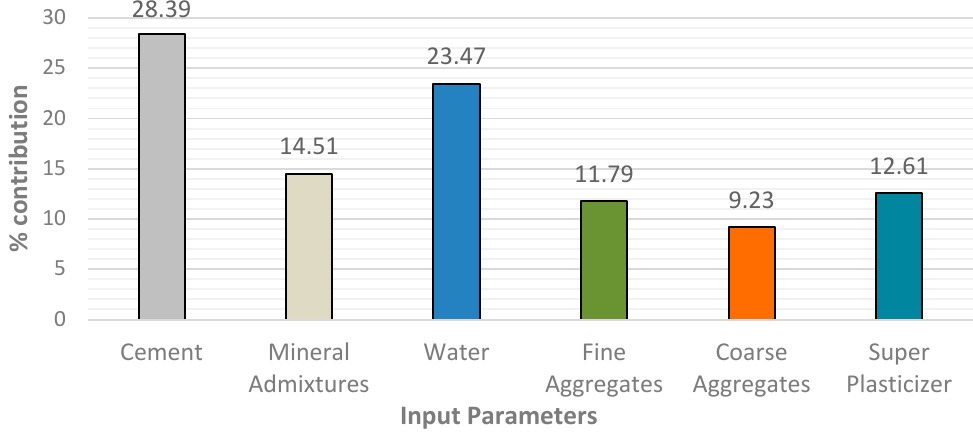
Figure 22. Contribution of input parameters to compressive strength of SCC with RA.